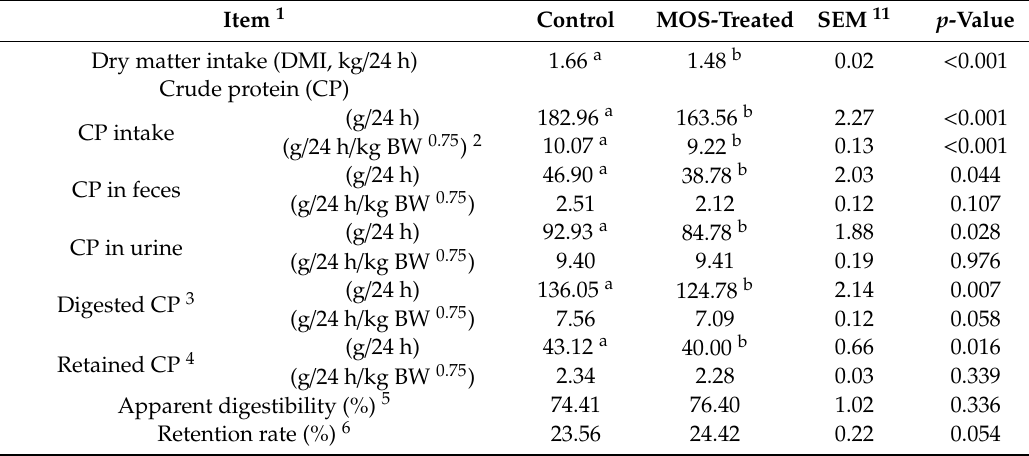
Table 4. In vivo nutrients and energy digestion and retention of control and MOS-treated sheep. Item